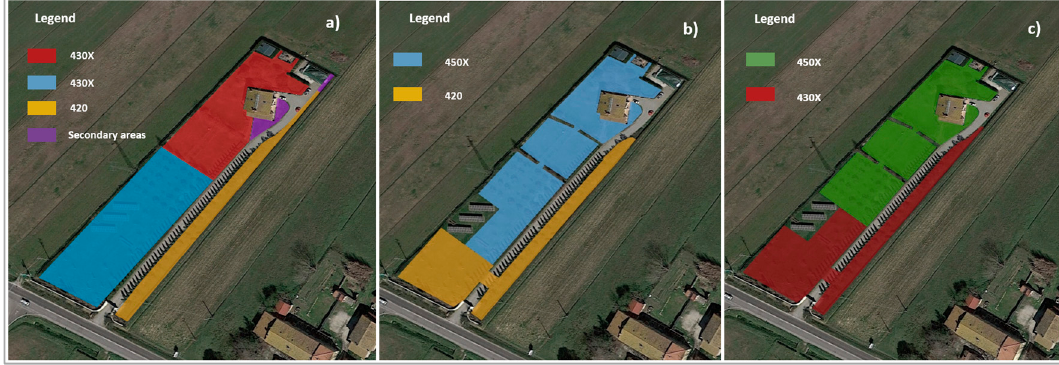
Figure 2. Areas cut by autonomous mowers: ( a ) Current state; ( b ) Scenario 1; and ( c ) Scenario 2.